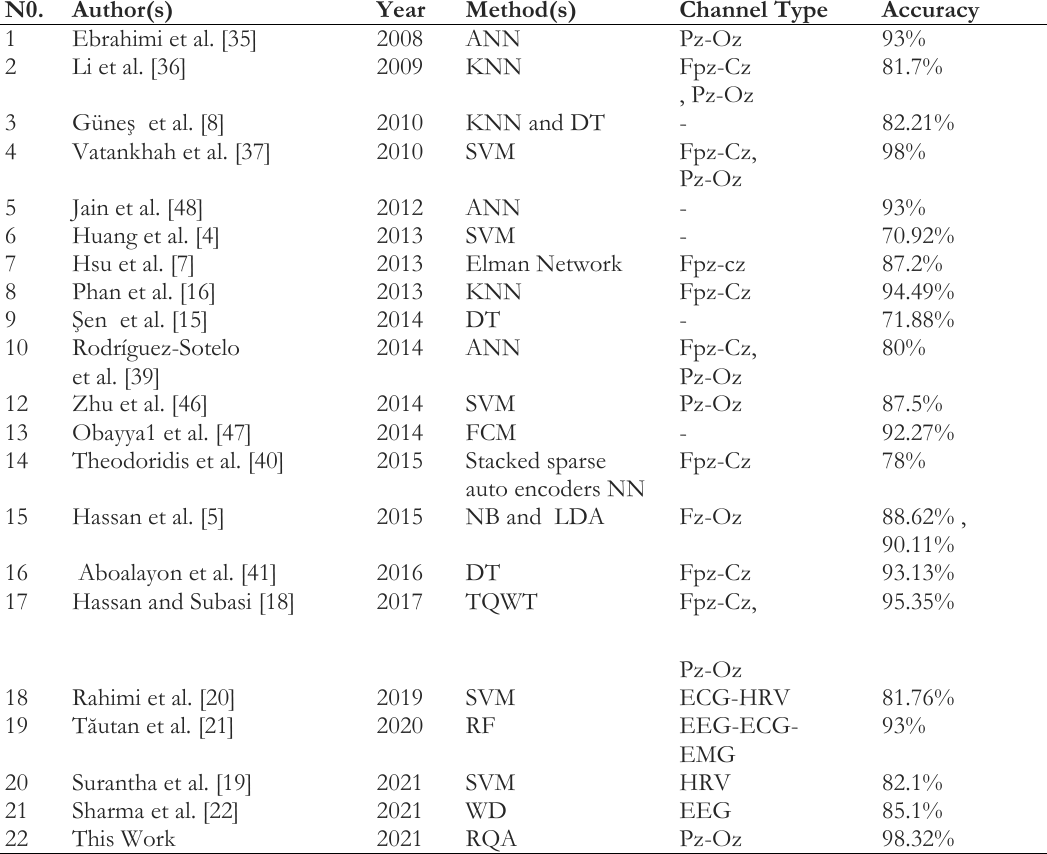
Table 6. Compression techniques applied to EEG data for sleep stages